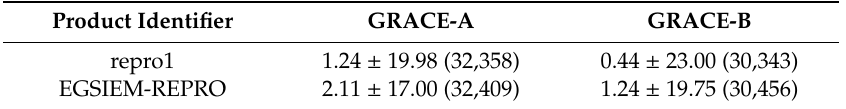
Table 4. Mean and standard deviation in mm of Satellite Laser Ranging (SLR) residuals of kinematic orbits over the entire year 2008. The number of used normal points in the analysis is given in brackets.